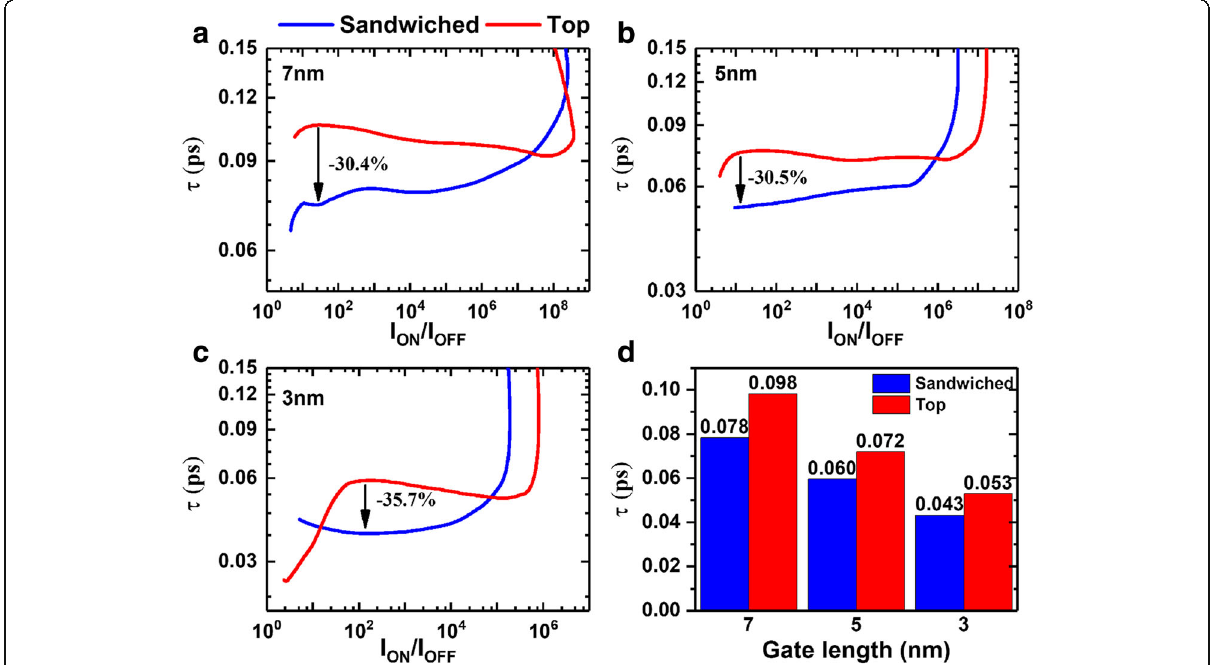
Fig. 6 Intrinsic delay as a function of on-off ratio at node. a 2019, b 2021, and c 2024 nodes, respectively. d Comparisons of intrinsic delay following HP requirement of